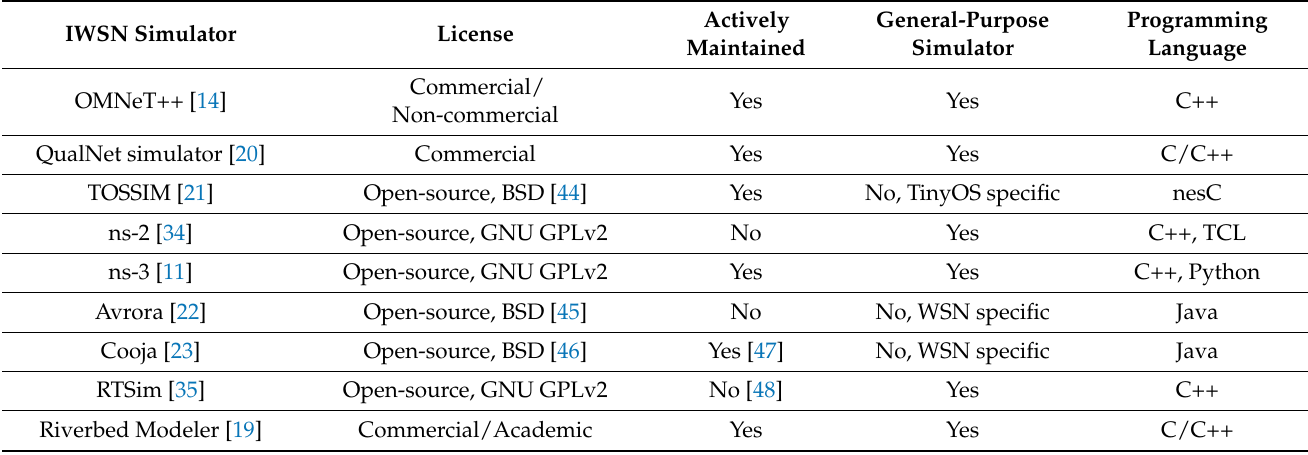
Table 2. Criteria used for selecting the IWSN simulator.